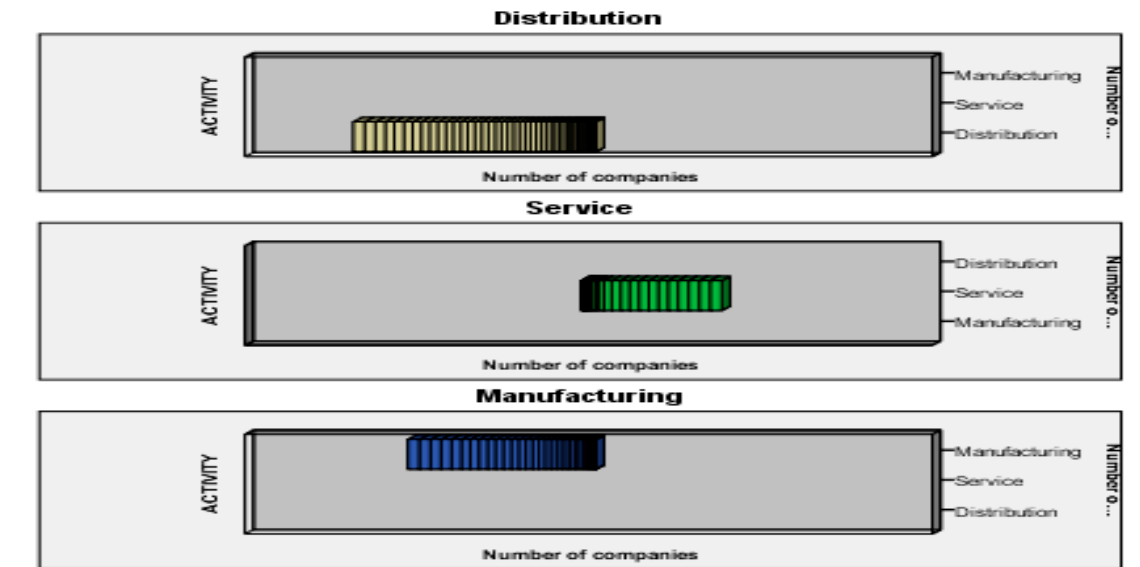
Figure 2. Descriptive analysis according to the number and activity of investigated businesses. Data processing by the authors.